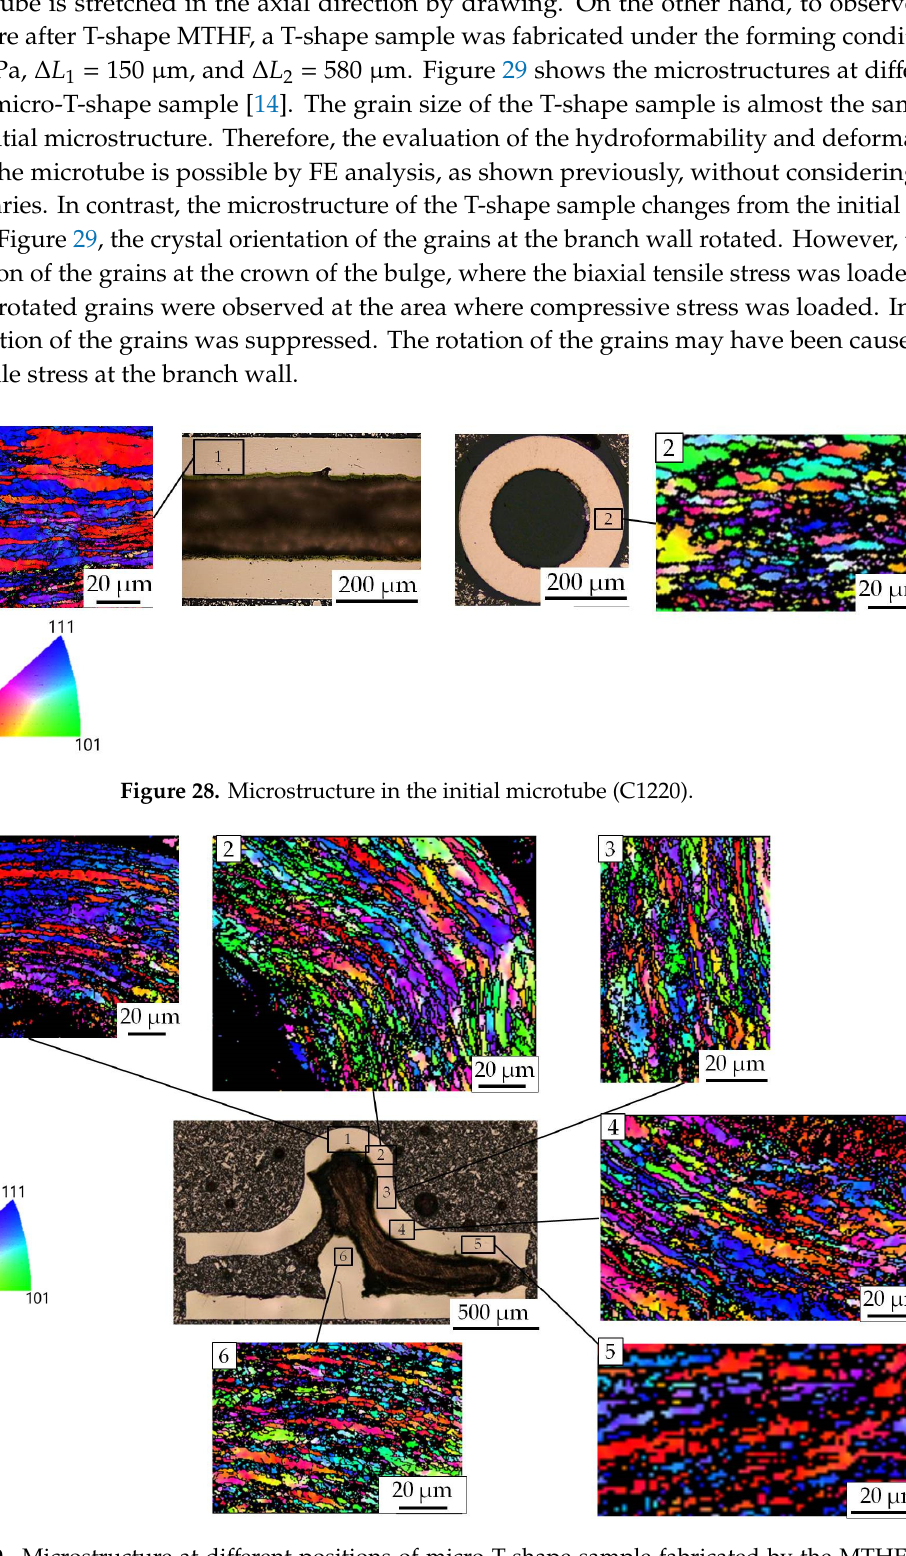
Figure 29. Microstructure at different positions of micro ‐ T ‐ shape sample fabricated by the MTHF process (C1220).